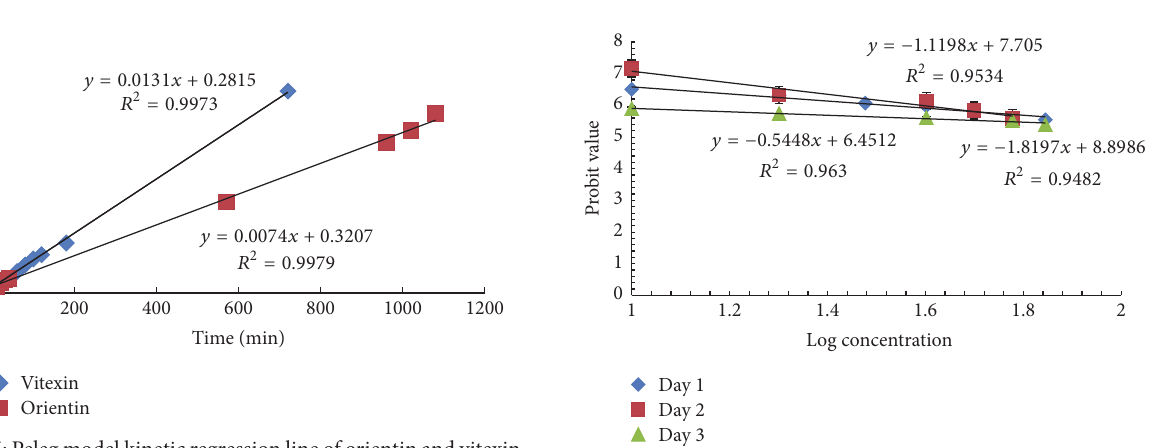
Figure 8: Determination of IC 50 values on various concentration of Clinacanthus nutans extracts (24, 36, and 48 hrs of treatment).